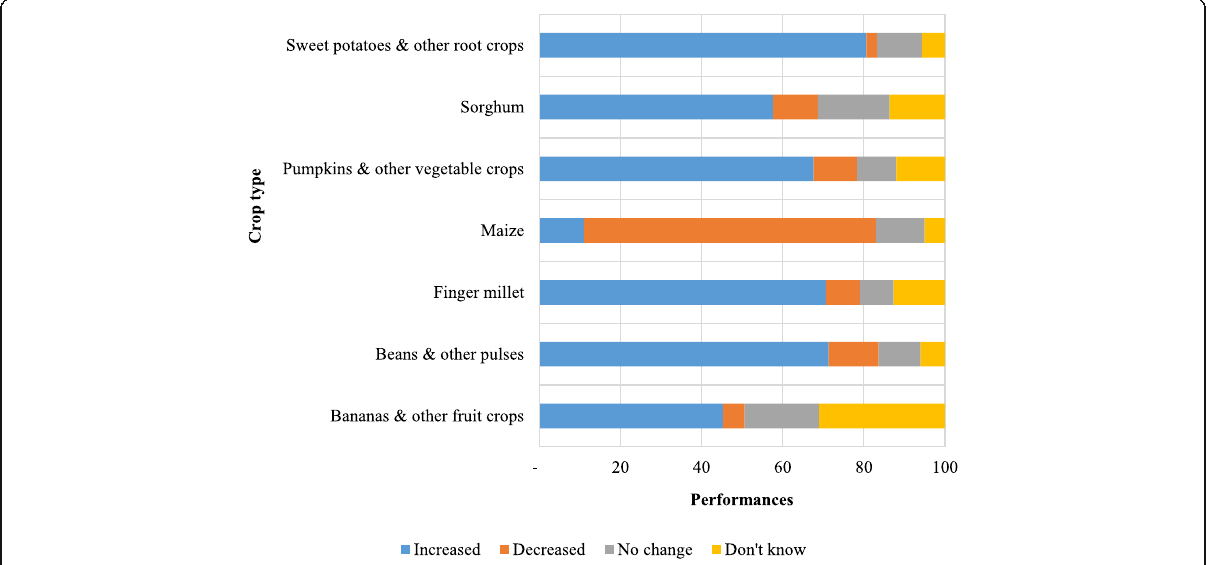
Fig. 3 Crop performances under different climatic situations in the study area between 2000 and 2015 (Source: Field Data,